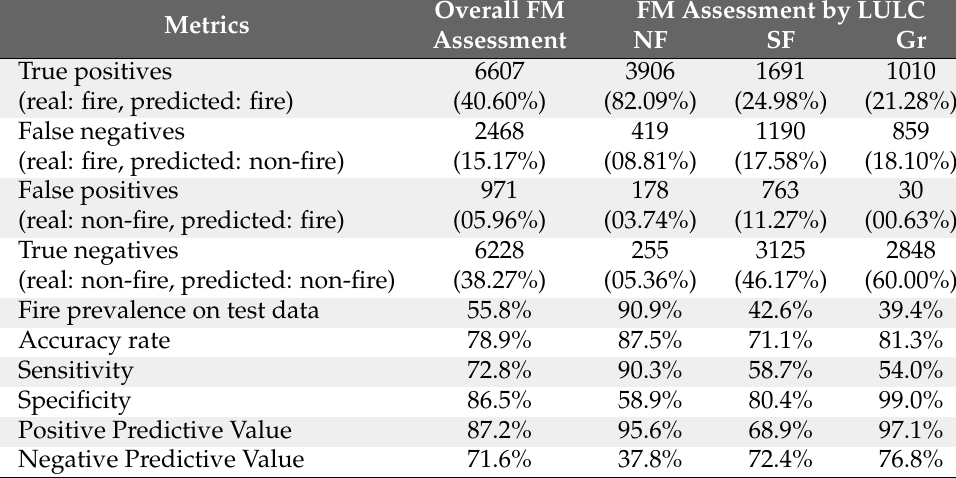
Table 1. Overall and Land Use and Land Cover (LULC) final model prediction assessment metrics. NF: Natural Forest; SF: Savanna Formation; Gr: Grassland; BA: Burned Area. True positives, false positives, false negatives and true negatives. Results in absolute numbers and percentage.